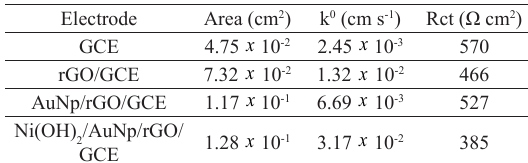
Table 1. Study of the electrochemically active area and k 0